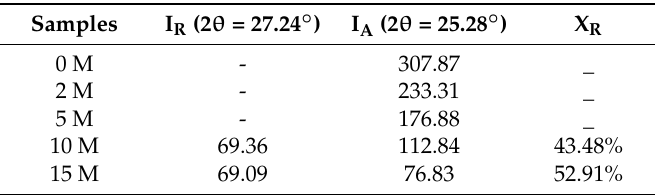
Table 1. Rutile content of